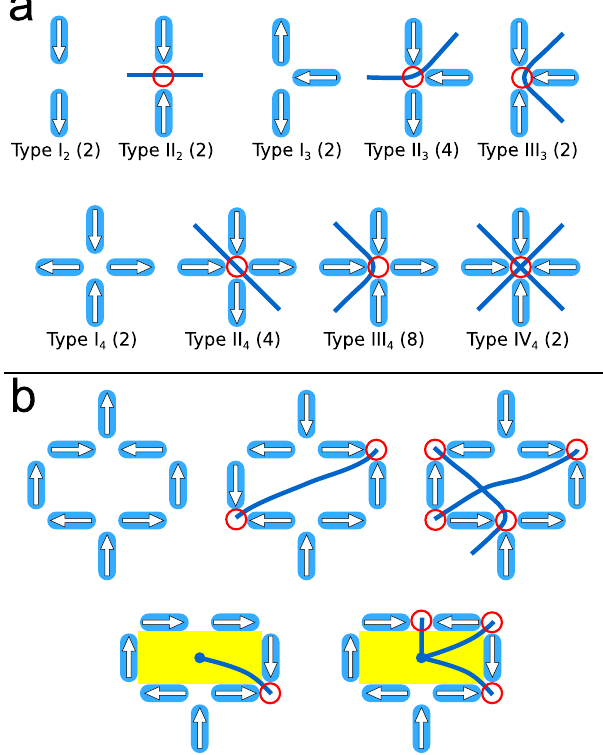
Fig. 2 Vertex types and string representation. a Vertex moment con fi gurations for different vertex coordination numbers, z = 2, 3, and 4, arranged in order of increasing energy, where the arrows indicate moment direction and each red circle denotes an excited state of the vertex (i.e., an unhappy vertex). The numbers in parentheses show the degeneracy for each given vertex type. The blue lines represent string segments “ connecting ” the plaquettes through the unhappy vertices. b Examples of moment and string con fi gurations for peripheral (unshaded) and interior (yellow-shaded) plaquettes. Because of the SFI lattice geometry, a peripheral plaquette is connected by an even number of unhappy vertices, and an interior plaquette is connected by an odd